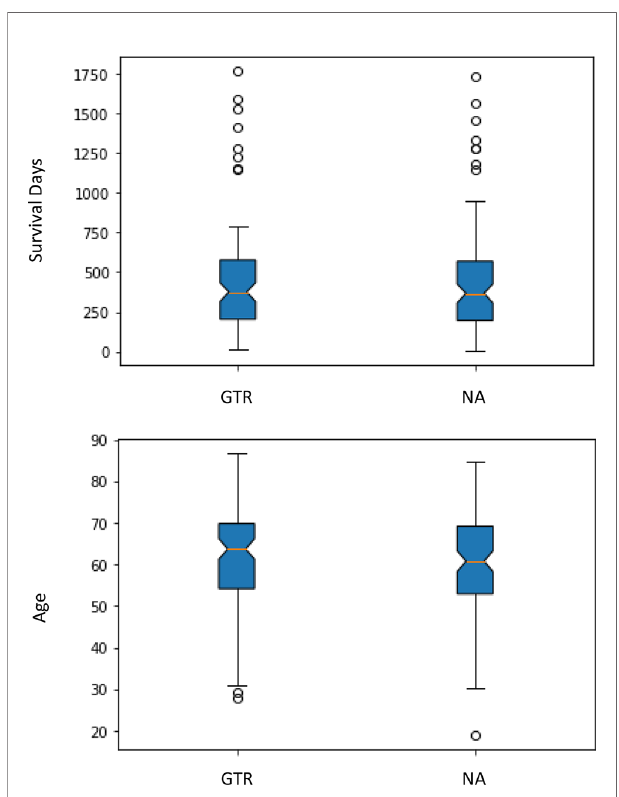
FIGURE 1 | Differences in age and survival by resection